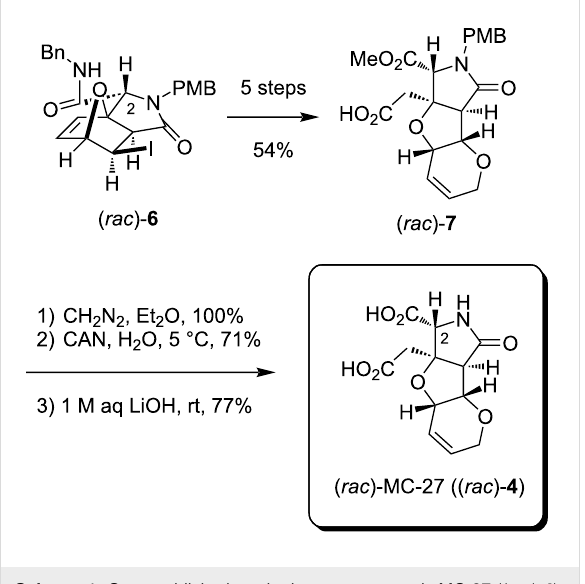
sponsible for the neuroactivity (see above). Herein, we also report the enantiospecific synthesis and evaluation of the novel eight-membered azacyclic analog (2 R )-TKM-38 ( 3 , see Figure 1) and the antipode 3*